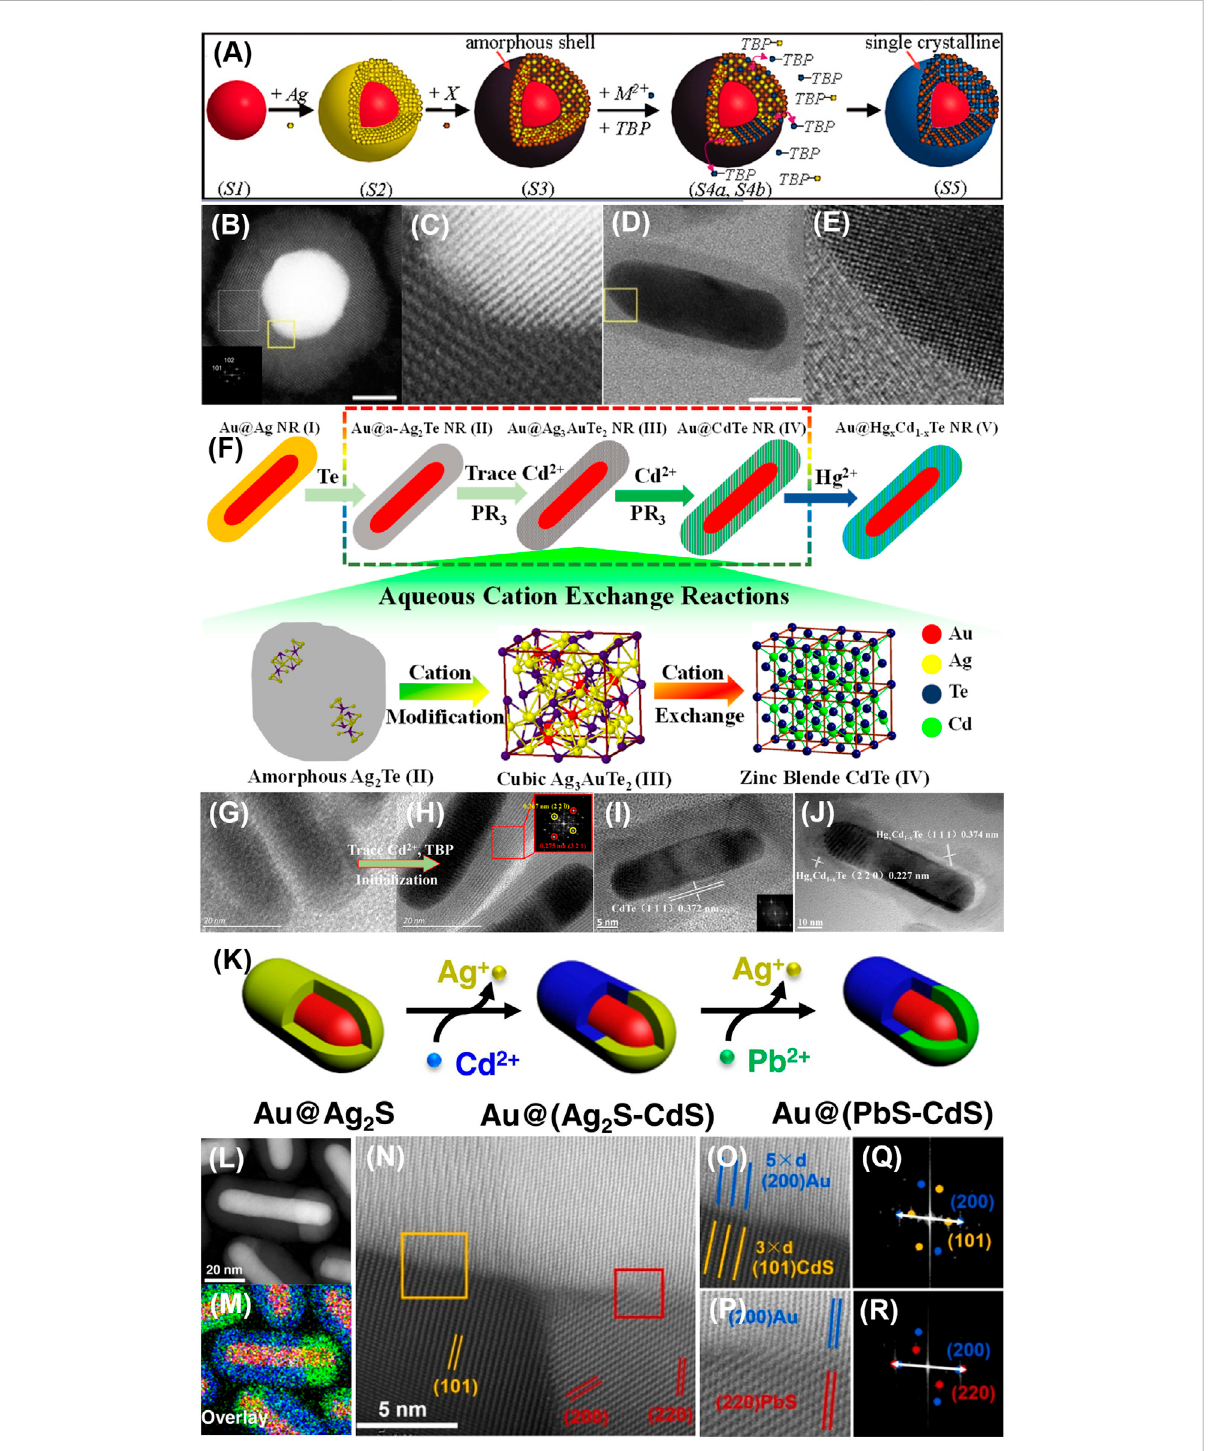
FIGURE 2 (A) SchematicofNonepitaxialgrowthprocess.AdaptedfromZhangetal.(2010a). (B,C)